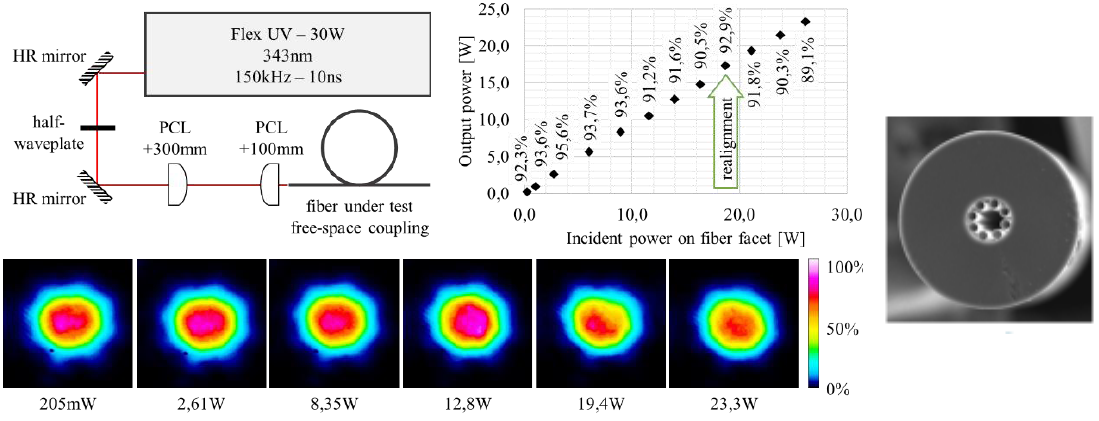
Figure. 3 : Power scaling: Schematic of the optical set-up; HR: High-Reflection; PCL: Plano-Convex Lens (top right), output against input with transmission coefficients (top right) with corresponding output beam profile from a CMOS camera (bottom).. Right : end face of the hollow core